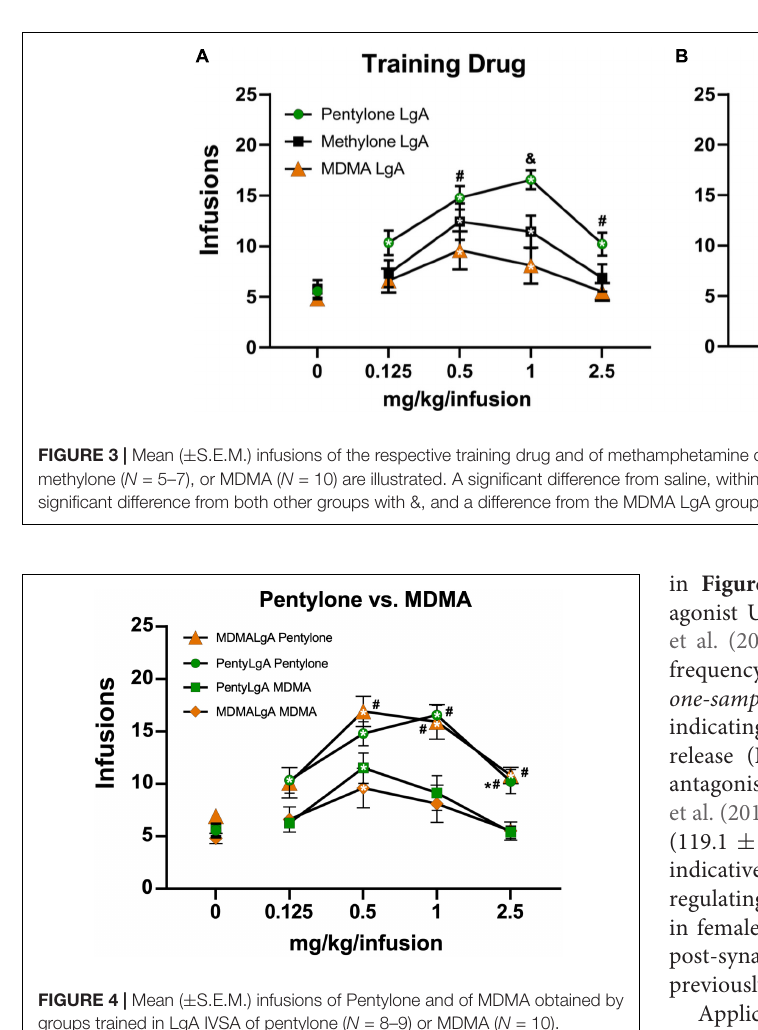
groups [ F (2,124) = 1.545, P = 0.2173, Saline: 9.0 ± 0.3 ms